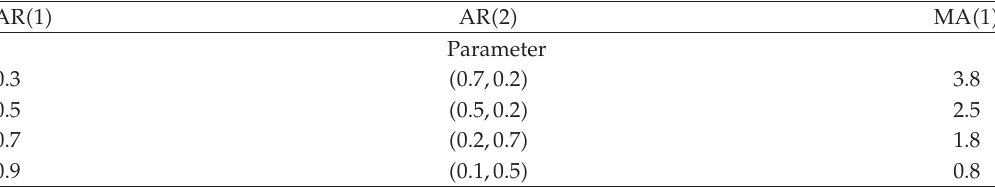
Table 1: Autoregressive models used in the